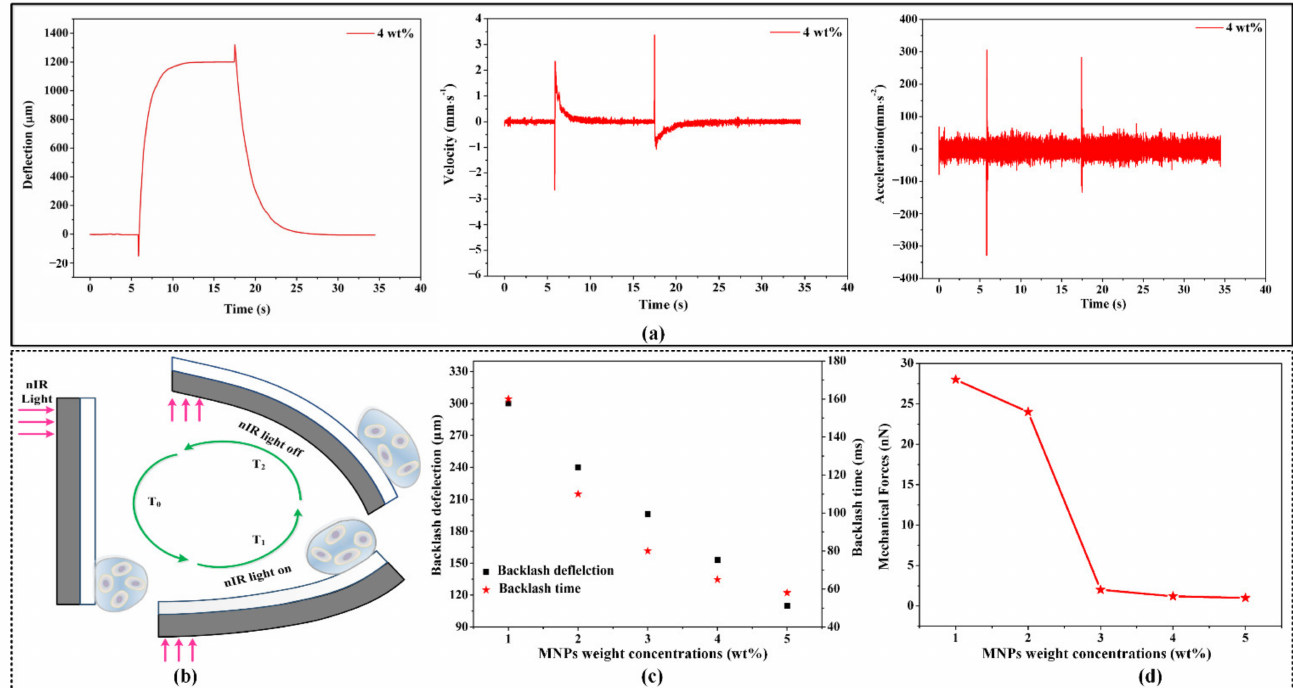
Figure 4. Analysis of mechanical force loading on cells based on velocity and acceleration curves. ( a ) Velocity and acceleration curves of the two-step photomechanical bending process. ( b ) Diagram of the soft bilayer two-step photomechanical-bending-induced mechanical force loading. ( c ) Backlash bending comparisons under various MNP weight concentrations. ( d ) Theoretical extracellular mechanical force exerted on